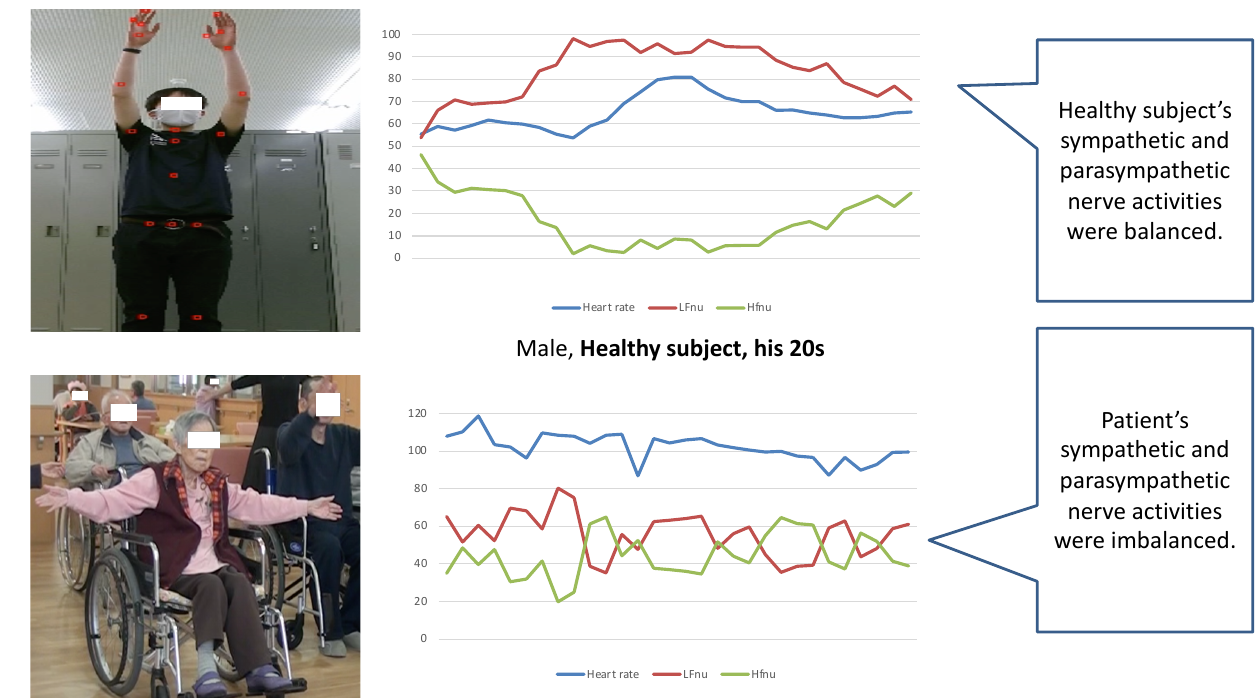
Figure 5. Synchronized image of (1) HRV evaluated using ECG, and (2) transactive relational data recorded by digital video recording during range-of-motion exercise. Note (Figure legend). The HRV analysis, acceleration score, and ROM of upper limbs were measured and analyzed using the GSM’s Bonaly Light. In healthy subjects, low-frequency (LF) normalized units (LFnu: sympathetic nerve activity) were increased and high-frequency (HFnu: parasympathetic nerve activity) was decreased during exercise. Patient’s antagonistic state of LFnu and HFnu was unclear. From this, it was considered that patients’ sympathetic and parasympathetic nerve activities were imbalanced by reduced